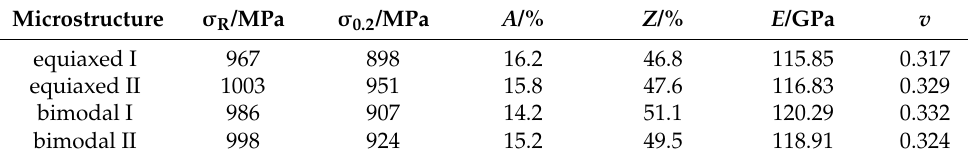
Figure 2. Stress–strain curves of different forged TC4 titanium alloys. Table 3. Room-temperature tensile properties of different forged TC4 titanium